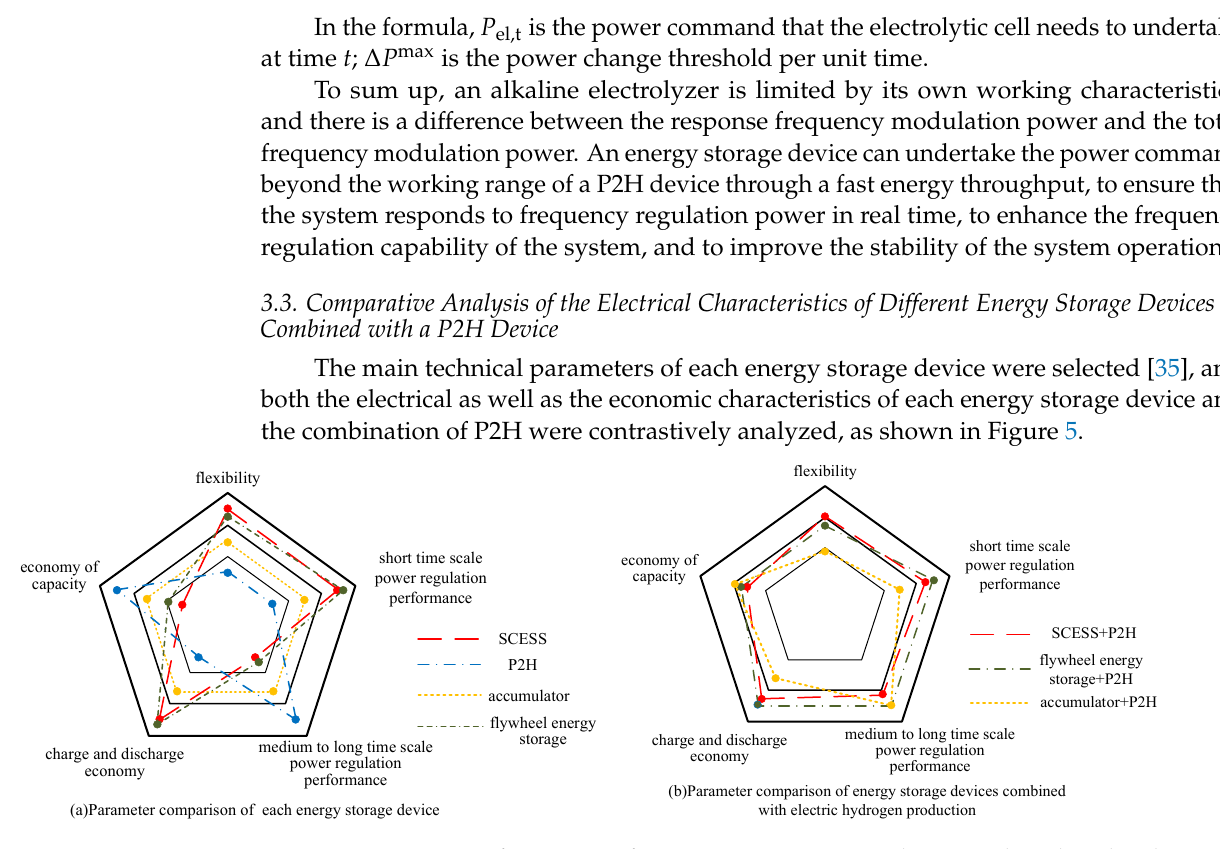
Figure 5. Comparison of parameters for various energy storage devices and combined with P2H.